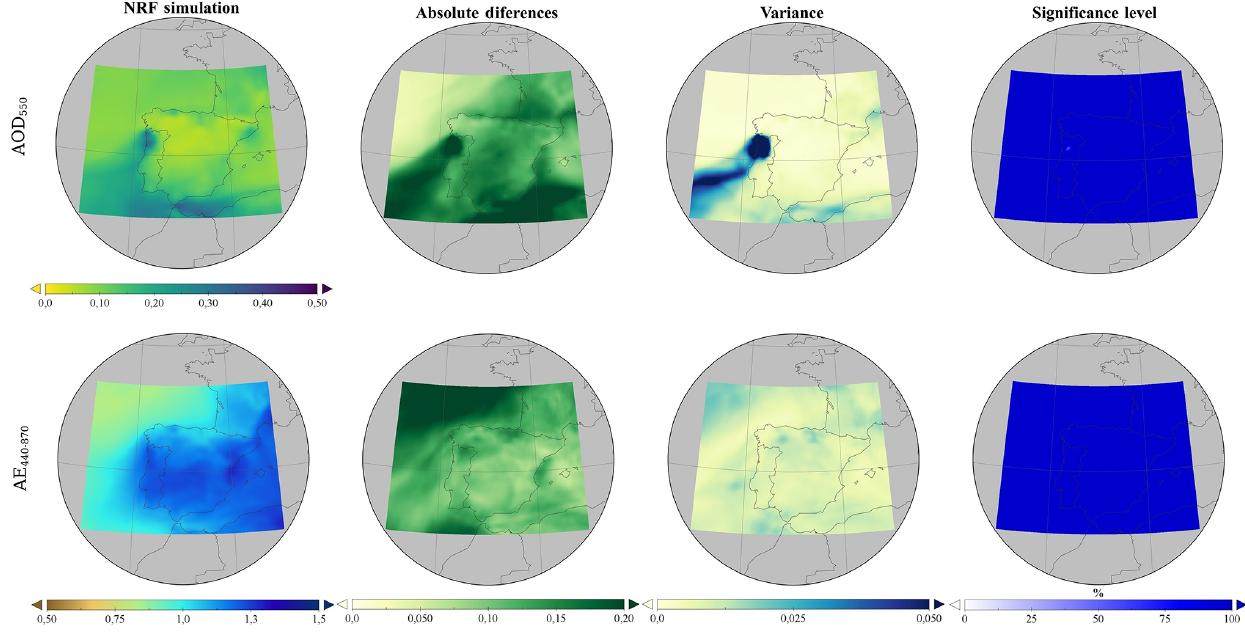
Figure 3. As Fig. 2 but for the fire episode (temporal mean from 25 July to 7